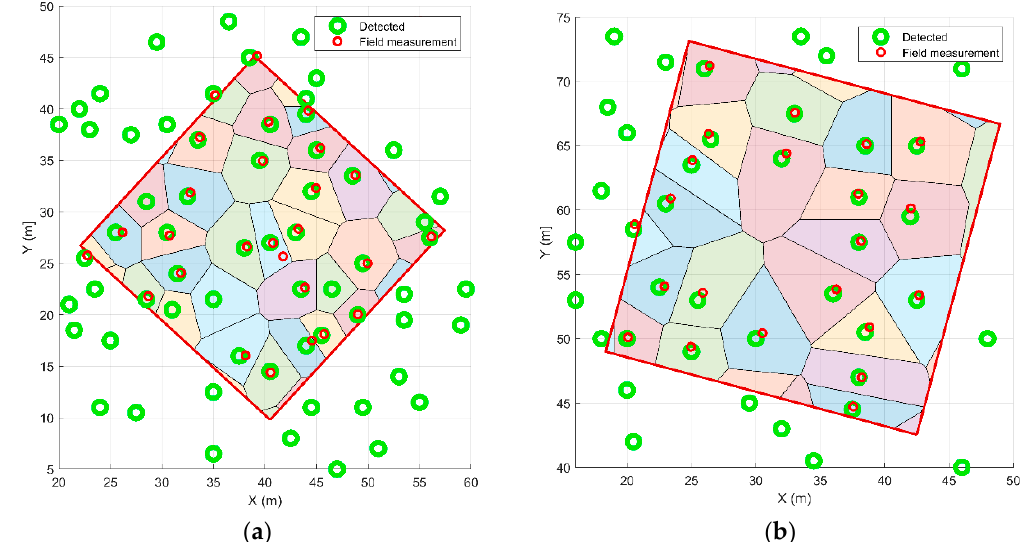
Figure 5. Tree positions automatically detected in point clouds and field-measured: (a) spruce plot (plot 2); (b) pine plot (plot 5). Colored polygons represent Voronoi diagram used to segment the plot area into regions of individual trees.